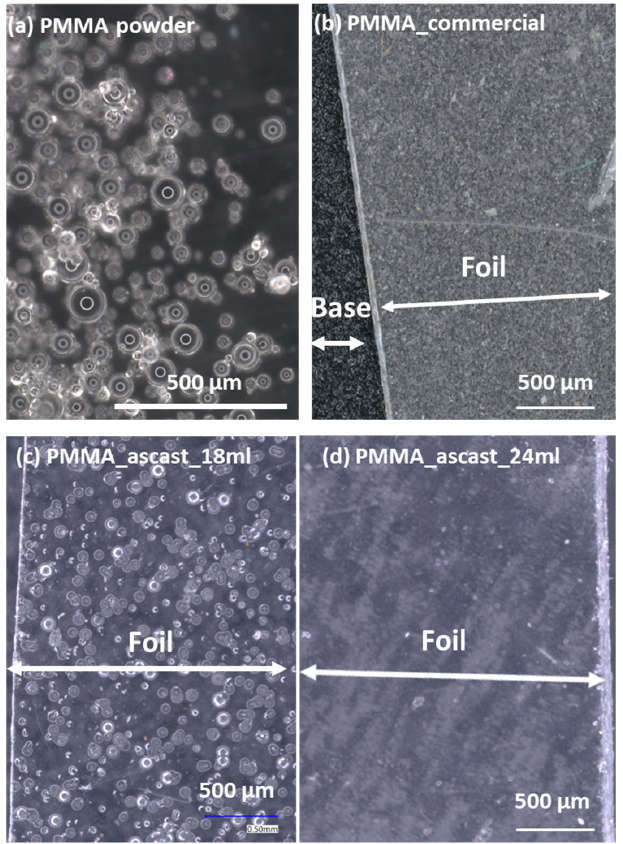
Figure 2. ( a ) Surface image of PMMA powder and ( b ) Commercial PMMA foil ( c , d ) prepared PMMA foils from 18 and 24 mL concentrations.